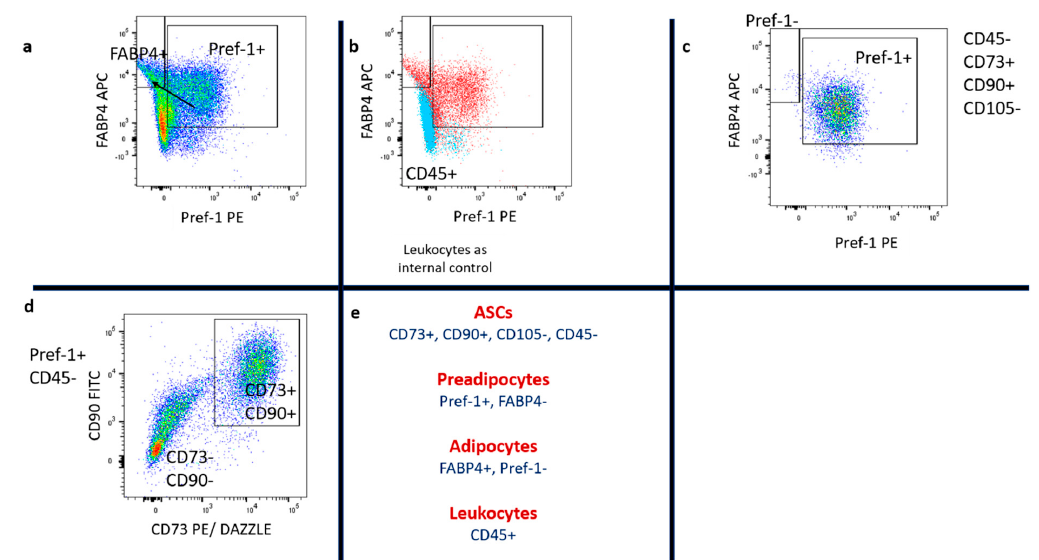
Figure 4. Part II of the gating strategy. In ( a ), intact cells expressing Pref-1 and FABP4 were gated. Preadipocytes lose Pref-1 expression and enrich FABP4 during further differentiation to mature adipocytes. ( b ) Preadipocytes and adipocytes were gated by using leukocytes as an internal control. ( c ) CD45-, CD73 + , and CD90 + cells were assessed for Pref-1 expression. In the PLA sample, most stem cells expressed Pref-1. In ( d ), Pref-1 + and CD45- cells were assessed for CD73 and CD90 expression and found to be partly CD73 + and CD90 + . ( e ) Specific marker profiles for stem cells, preadipocytes, mature adipocytes, and leukocytes are